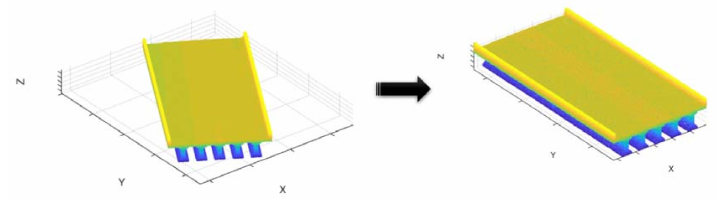
Figure 8. Point cloud data before ( left ) and after ( right ) 3D coordinate